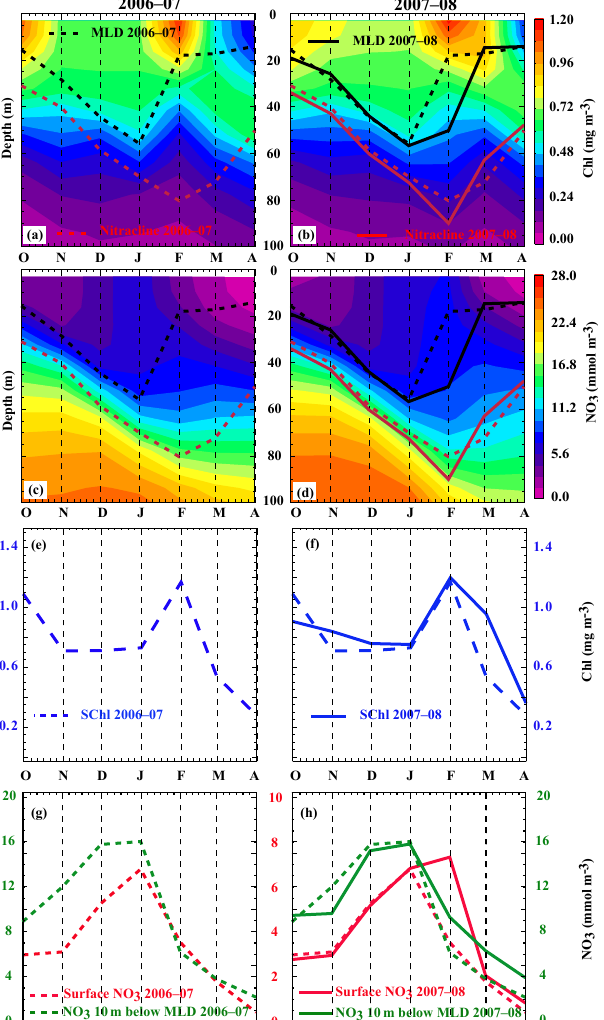
Figure 11. Depth–time section of NAS-averaged (a, b) chlorophyll (Chl) and (c, d) nitrate (NO 3 ) for (a, c) 2006–2007 and (b, d) 2007– 2008. The black lines indicate the MLD, thick for 2007–2008 and dashed for 2006–2007. The red lines similarly indicate the nitracline depth. Time series of NAS-averaged (e, f) SChl (blue curve) and (g, h) surface nitrate (red curve) and nitrate concentration 10m below the bottom of the MLD (green curve) for (e, g) 2006–2007 and (f, h) 2007–2008. In (f, h) , the 2006–2007 values have been reported as dashed curves to ease comparisons between the 2 years.